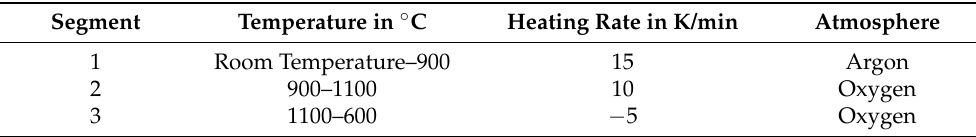
Table 5. Mass of chromite and chromite-MgO-mixtures after calcination and after oxidation.